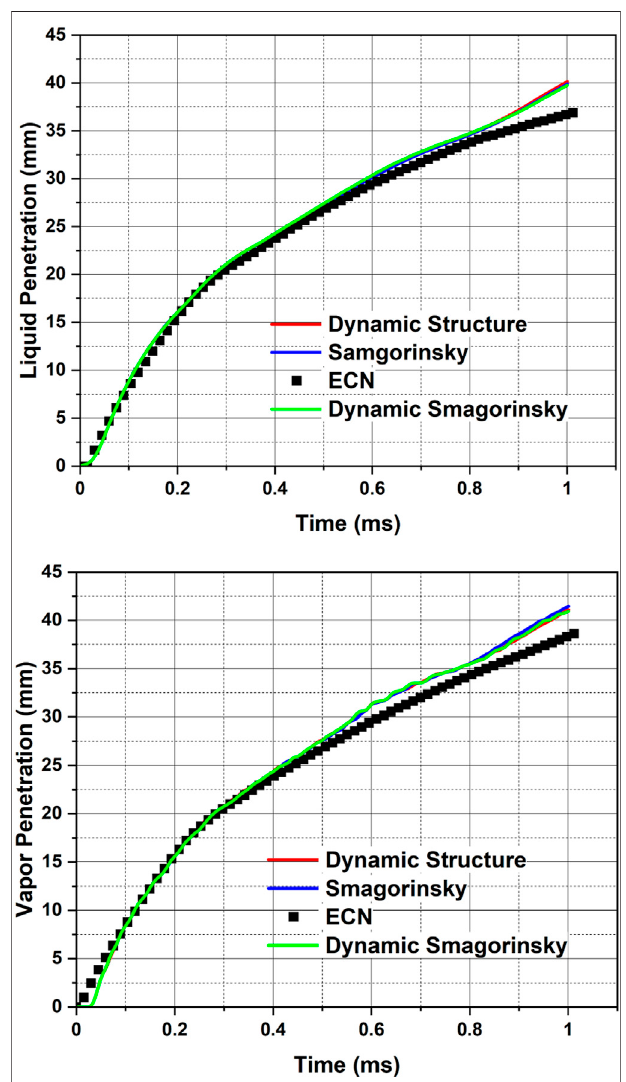
FIGURE 8 | Comparison of model predictions of liquid and vapor penetrations with the latest data measured by Sandia National Laboratories, available on ECN (ECN, 2022b) using different LES turbulence modeling approachesi.e., LESwith differentsub-gridmodels- Dynamic